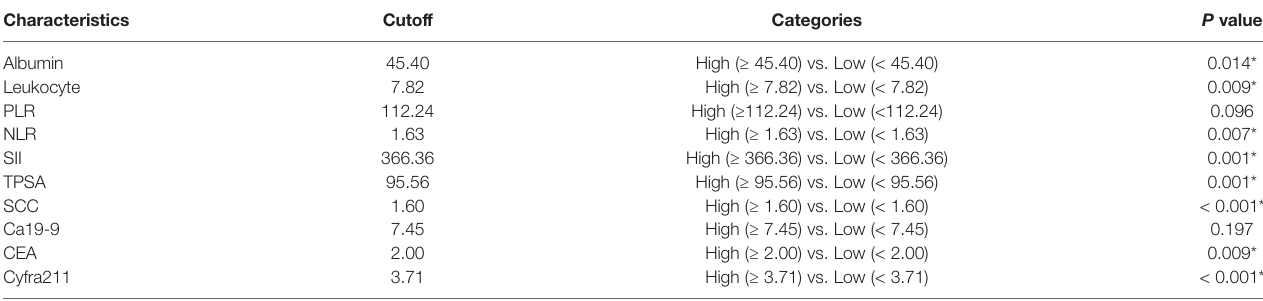
TABLE 2 | Cutoff level and univariate Cox analyses of hematological markers in the training set. Characteristics